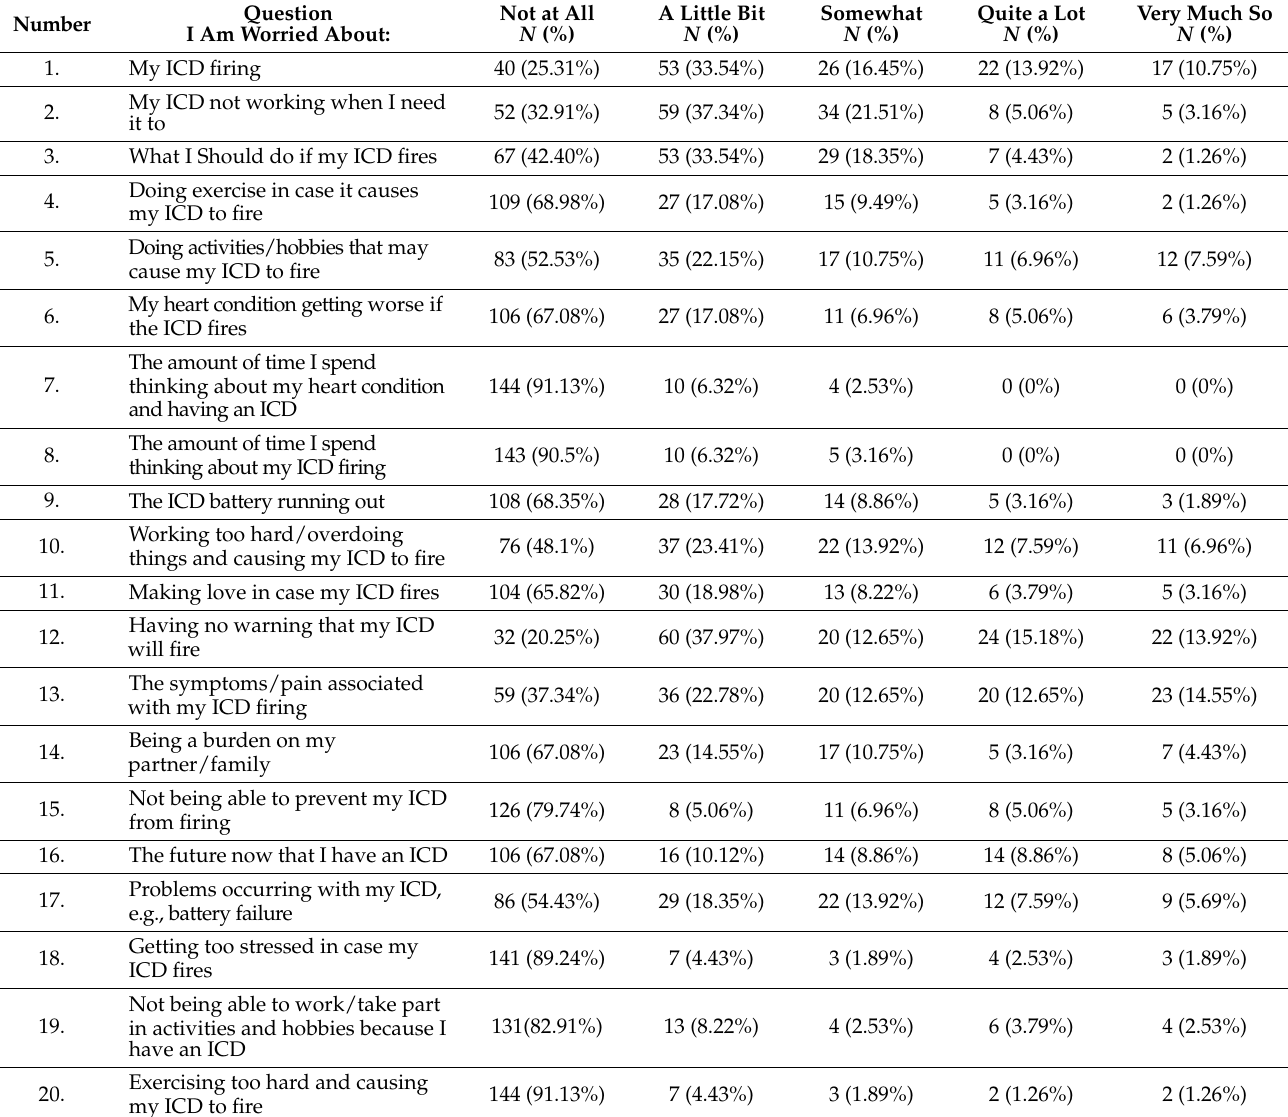
COPD—Chronic Obstructive Pulmonary Disease, ACE—Angiotensin-converting enzyme inhibitors and MRA—Mineralocorticoid receptor antagonists. The average number of concerns in all the examined patients was 7.56 ± 4.96. Exact data about specific concerns are presented in Table 2. Table 2. Characteristics of the severity of the concerns about the implanted cardioverter